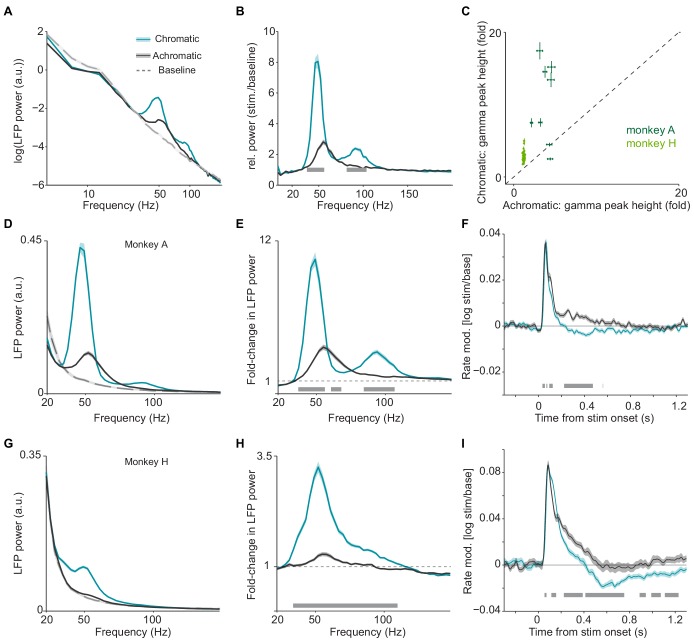
Analysis of LFP and multi-unit activity in response to large, uniform surfaces.(A) Average LFP power spectra for chromatic (turquoise), achromatic (black) and baseline (gray) conditions. LFP power was estimated using Discrete Fourier Transform of non-overlapping snippets of 500 ms with a Hanning taper. LFP spectra for all three conditions were normalized to the summed power (>20 Hz) for the baseline (gray) condition (see Materials and methods). (B) Average change in LFP power, expressed as fold-change, relative to baseline. (C) Scatter-plot for all the LFP recordings sites in two monkeys, showing the gamma-band amplitude (expressed as fold change) in chromatic and achromatic conditions. (D) Average LFP power spectra for chromatic (turquoise), achromatic (black) and baseline (gray) conditions for monkey A, using same estimation settings and normalization for power spectral density as in Figure 1 of main text. (E) Average change in LFP power, expressed as fold-change, relative to baseline. (F) Modulation of firing rate relative to baseline, expressed as log10 (stim/base), for monkey A. (G–I) as (D–F), but now for monkey H. (A–I) Shadings and error bars indicate standard errors of the means (see Materials and methods). Gray bars at bottom of figure indicate significance bars, obtained from permutation testing with multiple comparison correction across all frequencies and time points.